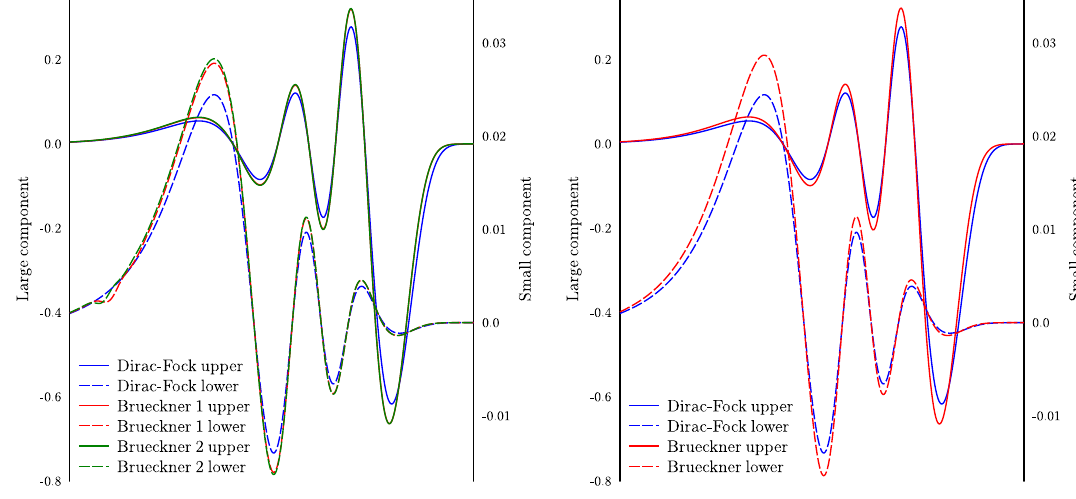
Figure 4. 6 s orbital for Au in Dirac–Fock and Brueckner approximations. Left panel: basis sets with 35 and 45 B-splines (labels 1 and 2, respectively); right panel: basis set of 24 B-splines with two additional Dirac–Fock orbitals in s